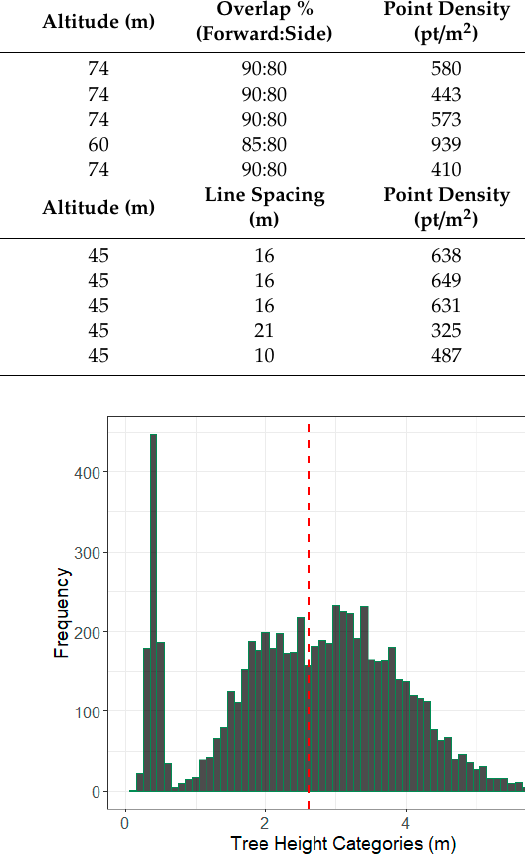
Figure 2. Distribution of tree heights across all four study sites binned at 0.1 m intervals. The red dashed line has been drawn at the mean tree height of all trees in the study (2.6 m).